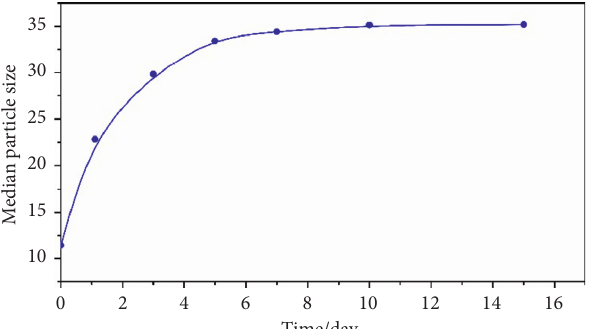
Figure 4: Curve of median particle size of submillimeter-scale SMG over time. The particle size of SMG gradually increased with the hydration time. After 10 days, the median particle size reaches a relative constant value.